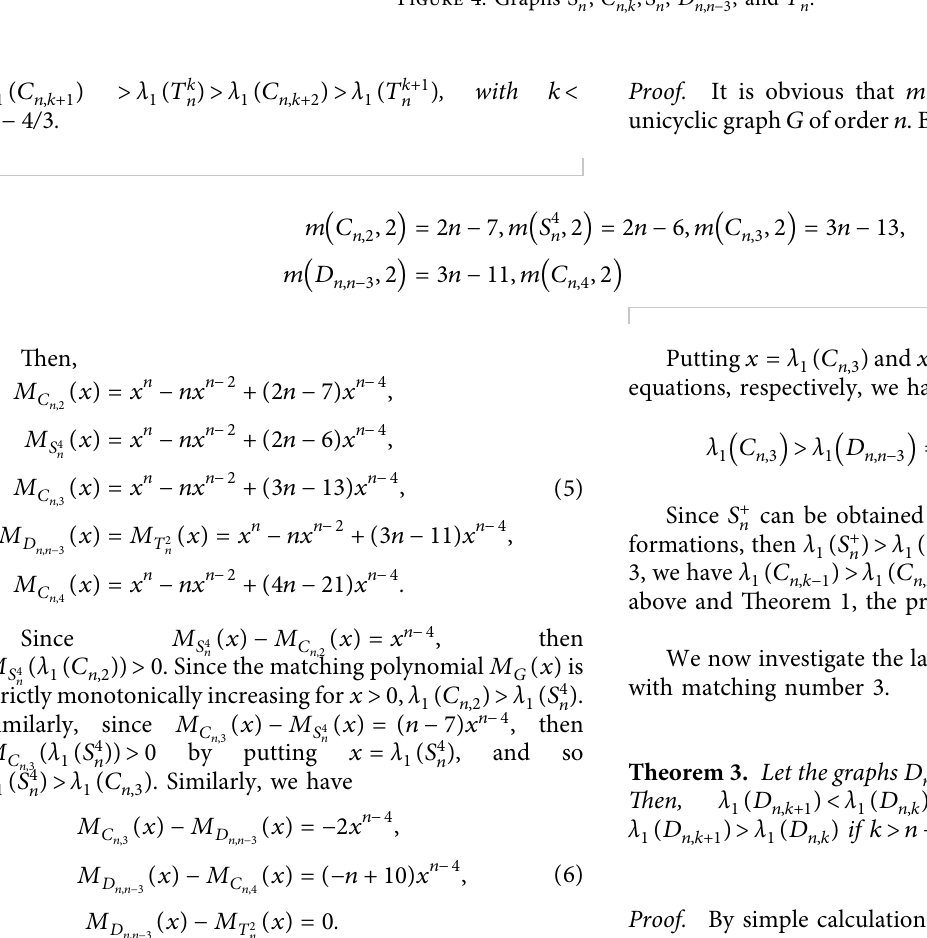
Figure 4: Graphs S +